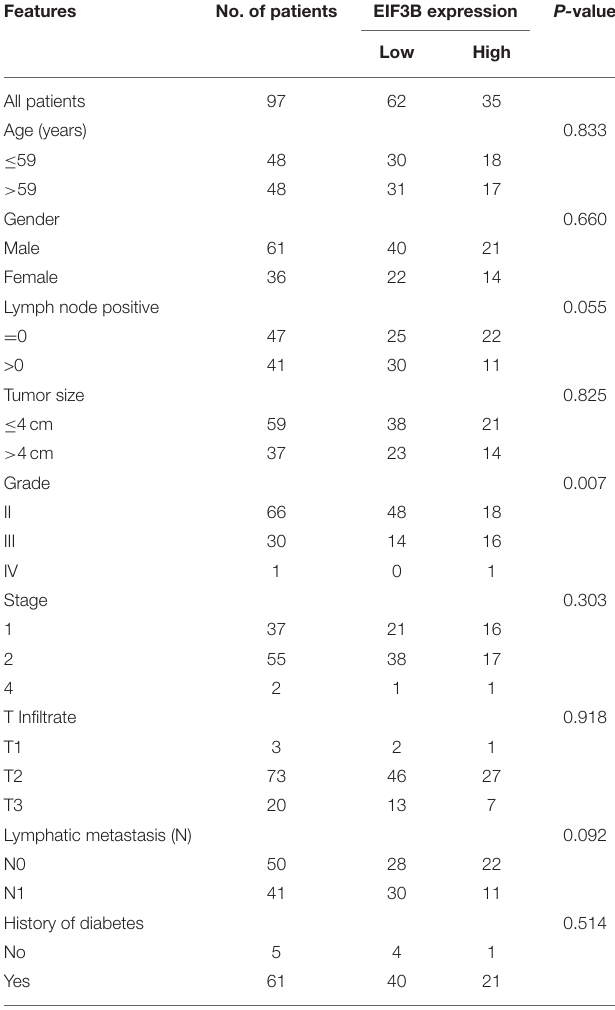
TABLE 2 | Relationship between EIF3B expression and tumor characteristics in patients with pancreatic cancer. Features